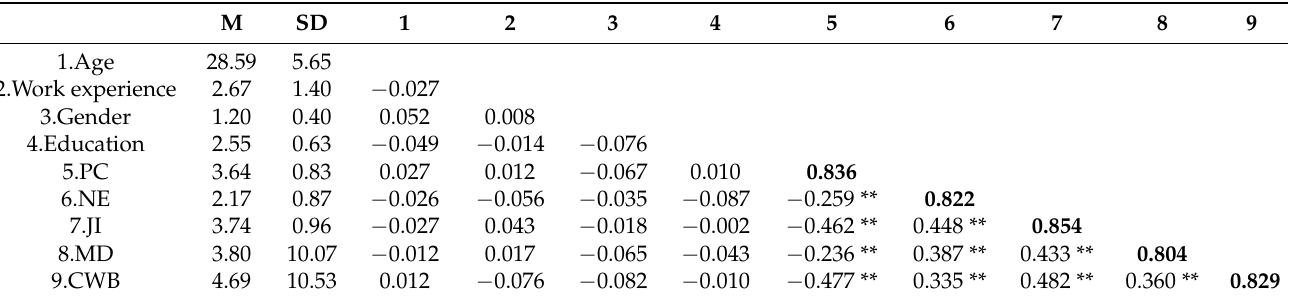
Table 1. Means, standard deviations, and correlations.